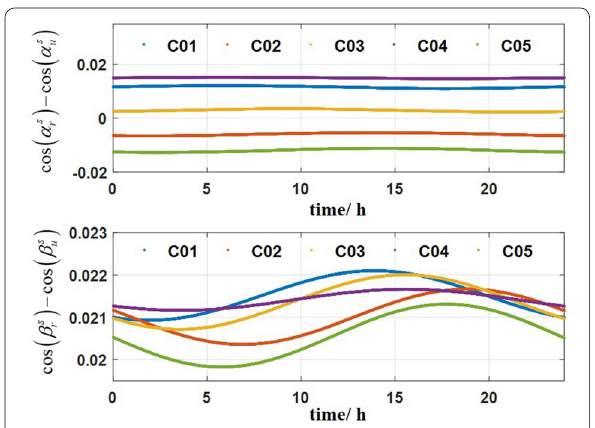
Fig. 1 Variations in cos (cid:31) α s r (cid:30) − cos (cid:31) α s u (cid:30) (top) and cos (cid:31) β s r (cid:30) − cos (cid:31) β s u (cid:30) (bottom) calculated using data from Beijing and Wuhan from February 20, 2018